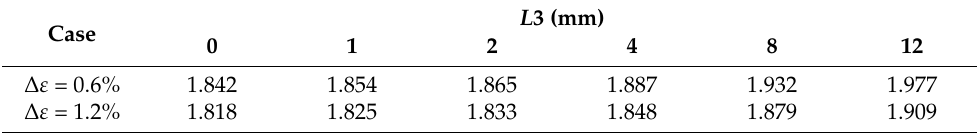
Figure 7. JRC specimen, the effect of L 3 length on the S2G ratio. Different responses at given ∆ ε are due to different K and n material parameters (Table 3). Table 8. JRC specimen ( L 3 length effect on S2G values, FEM JACOBS ).